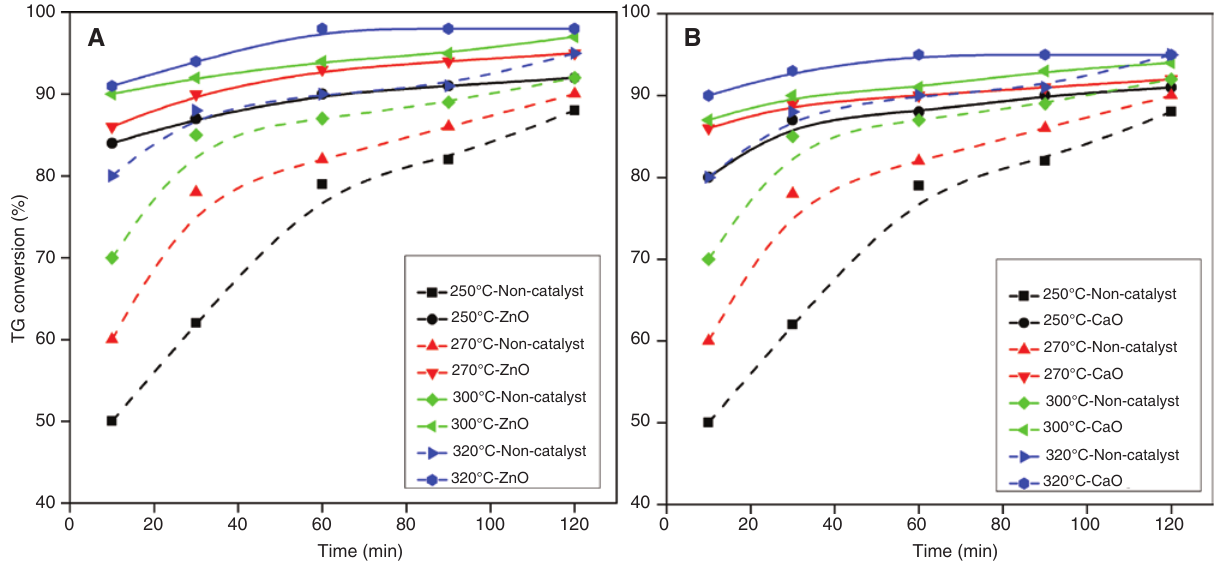
Figure 11: TG conversion as function of temperature at different reaction time of ZnO (A) and CaO (B) (reaction conditions: catalyst amount = 3%, molar ratio